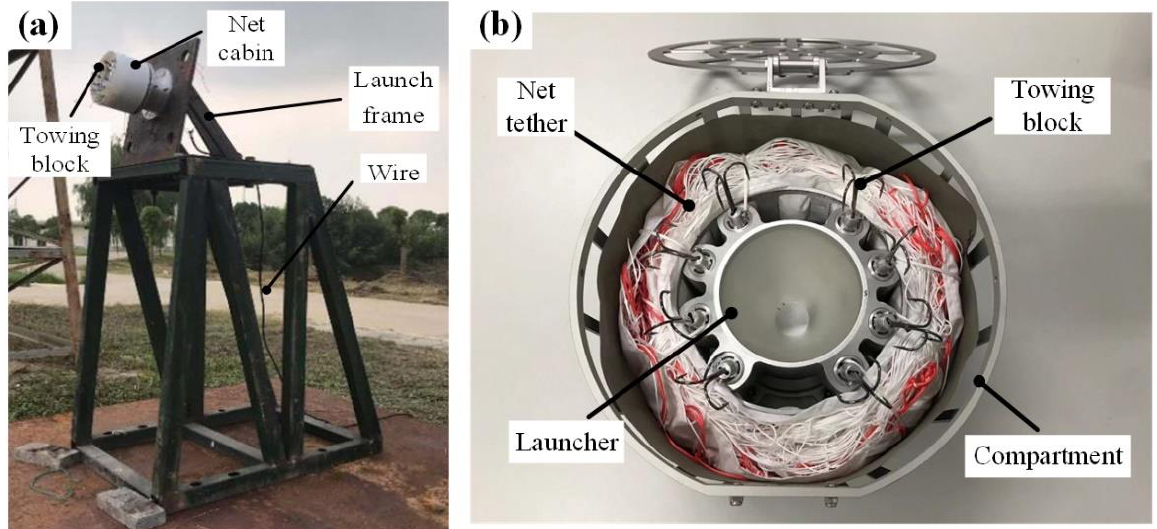
Figure 11. On-ground experiment. ( a ) Experimental setup. ( b ) Launcher of tether-net.